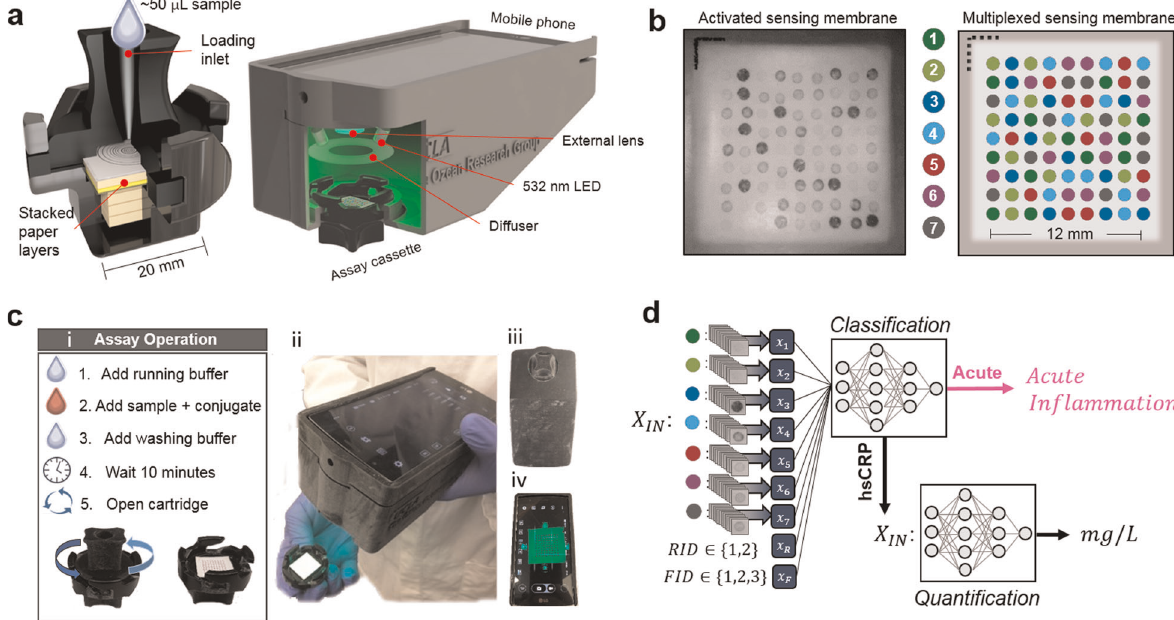
Fig. 1 Overview of the multiplexed vertical fl ow assay. a The VFA cassette cross-section and mobile-phone reader with the inserted VFA cassette to be tested. b The multiplexed sensing membrane contained within the VFA cassette. The algorithmically determined immunoreaction spot layout (right) contains seven unique spotting conditions, each of which uniquely reacts with the sensed analyte and the signal-forming Au NPs. A raw image of an activated sensing membrane taken with the mobile-phone reader is shown to the left. c (i) The VFA assay operation protocol (ii) The VFA cassette and mobile phone reader after the assay completion. The VFA cassette inserted into the mobile phone reader from the (iii) bottom and (iv) top view. d Block diagram of the computational analysis, showing the input features X IN which contain, the average signals from like-spotting conditions along with the reagent batch ID (RID) and the fabrication batch ID